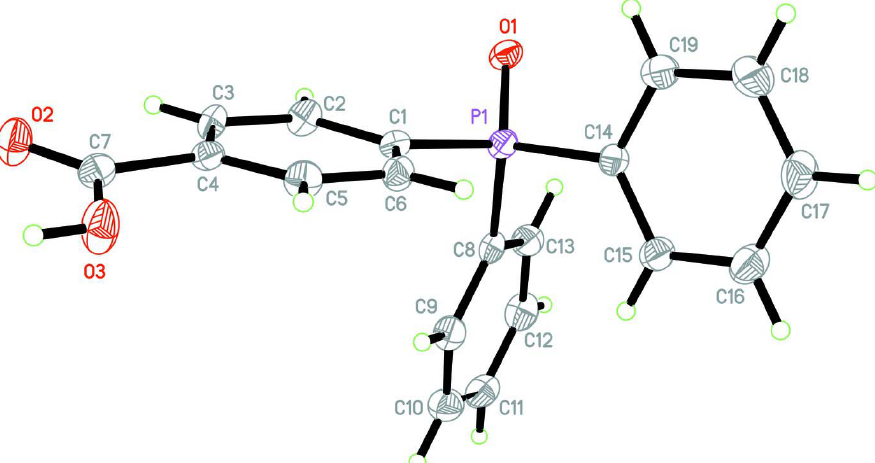
The structure of the title compound, showing the atomic numbering scheme. Displacement ellipsoids are drawn at the 30% probability